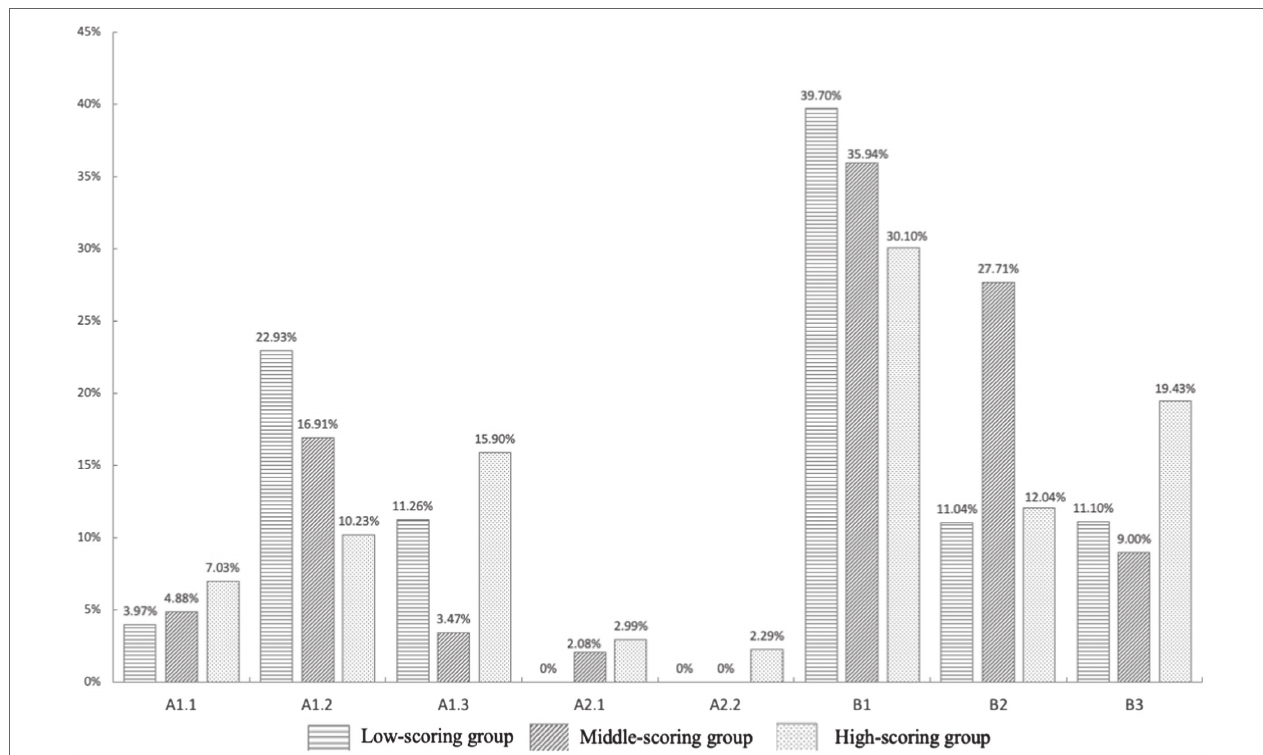
FIGURE 2 | Proportion of each interactional feature in the high-scoring group, middle-scoring group, and low-scoring